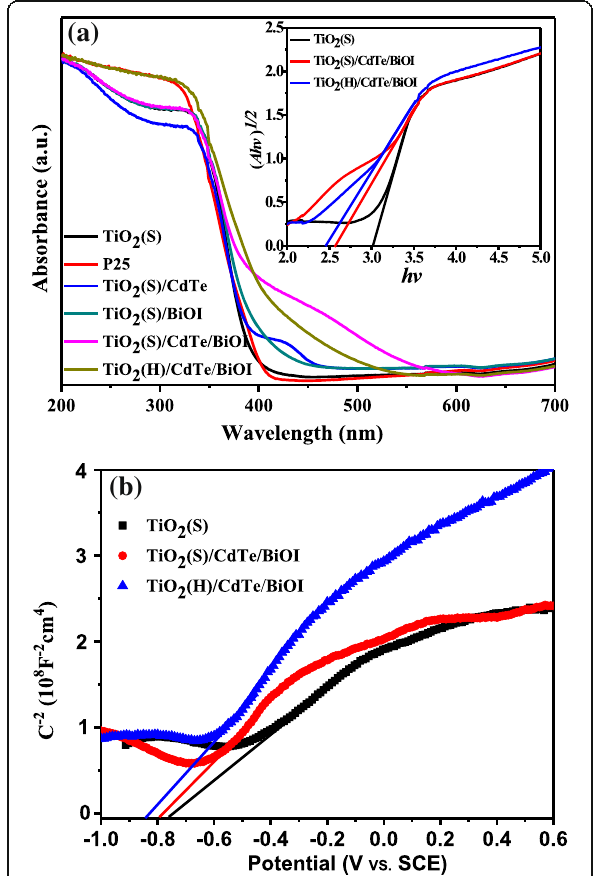
Fig. 6 a UV-Vis diffuse-reflectance spectra of all samples and corresponding Tauc plots of TiO 2 (S), TiO 2 (S)/CdTe/BiOI, and TiO 2 (H)/ CdTe/BiOI samples. b Mott-Schottky plots in 0.5 M Na 2 SO 4 at a frequency of 1 KHz of TiO 2 (S), TiO 2 (S)/CdTe/BiOI, and TiO 2 (H)/CdTe/BiOI